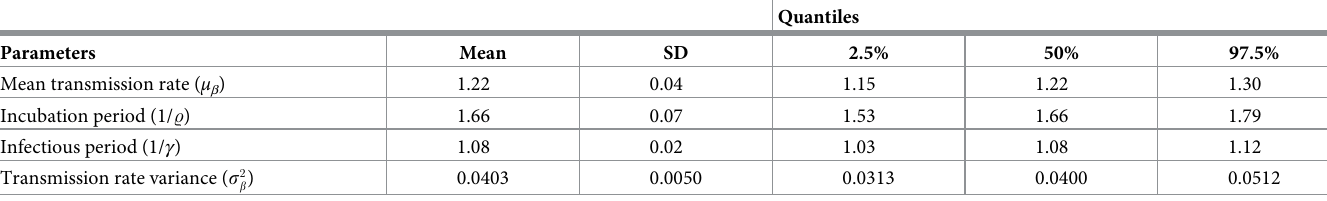
Table 2. Posterior summary statistics for Model 3 on nationwide